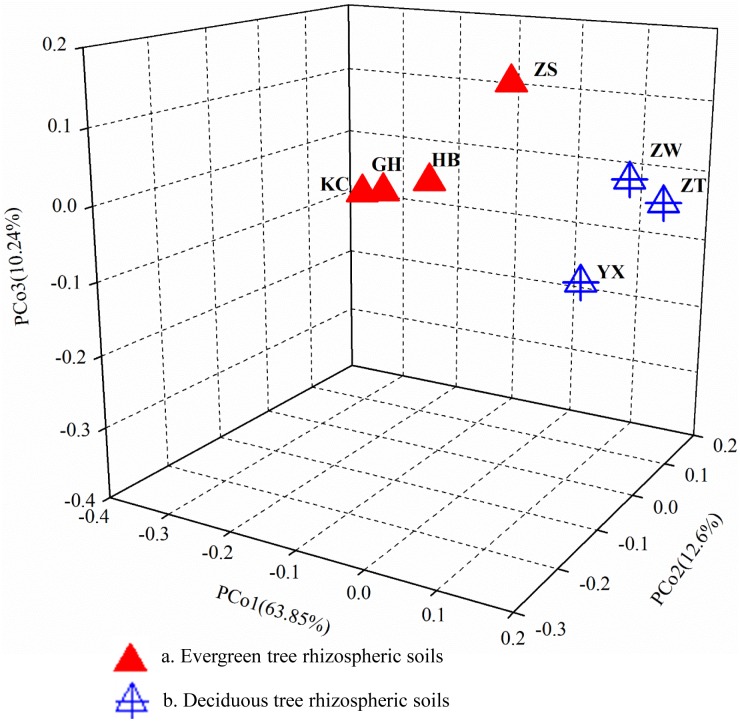
PCoA plot based on the weighted UniFrac distance.